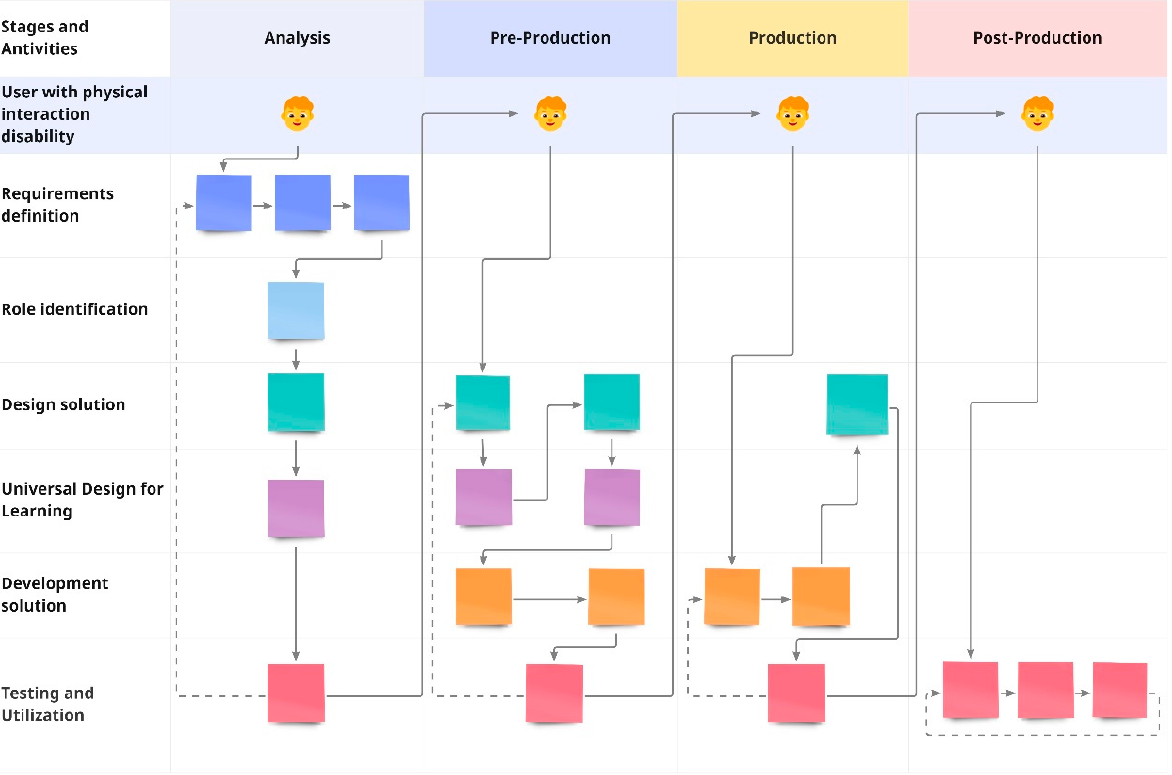
Figure 1. MEEXU 2 methodology development process.